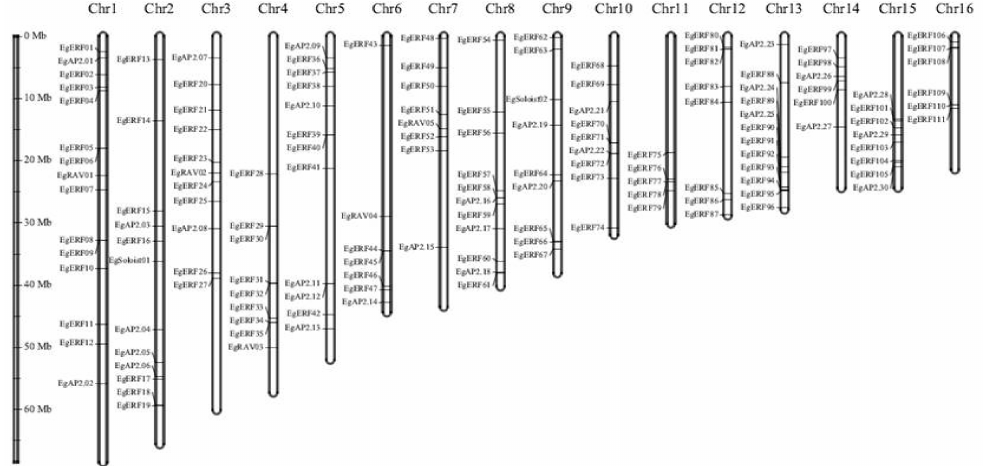
Figure 5. Chromosomal mapping of 172 oil palm AP2/ERF s. The length of the oil palm chromosomes is indicated on the vertical greyscale. The chromosome numbers (1–16) are indicated on the top of each